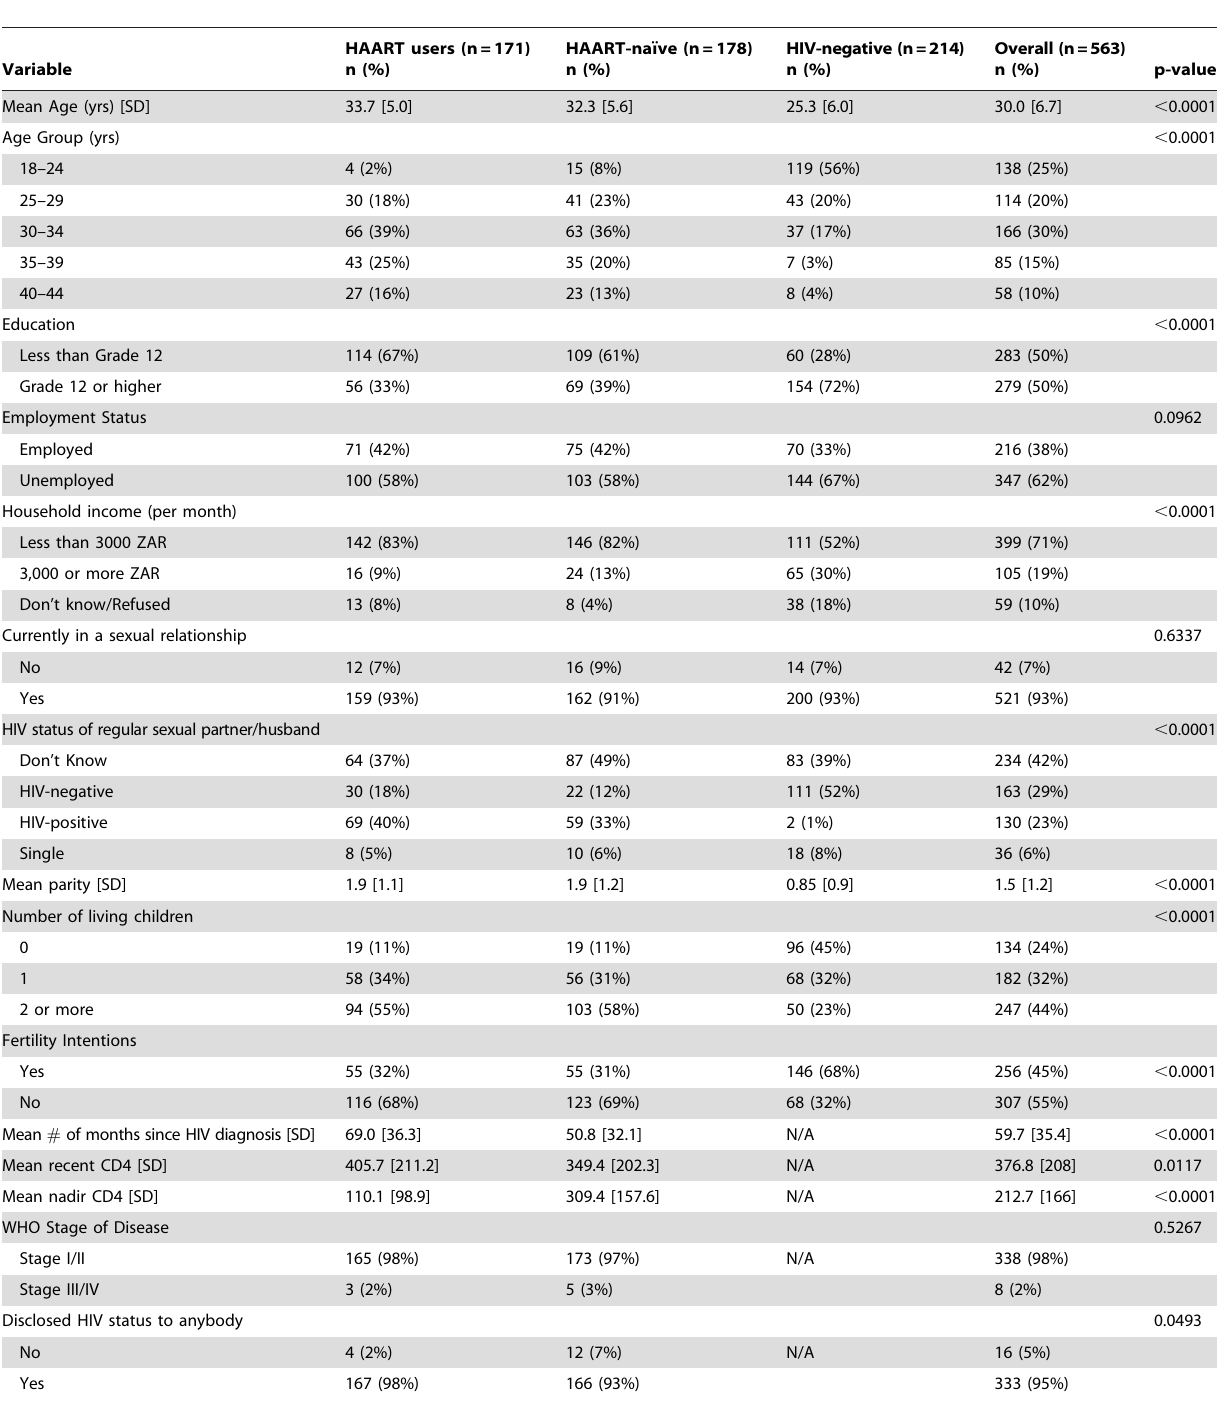
Table 1. Baseline characteristics of HIV-positive (HAART users and HAART-naı¨ve) and HIV-negative women (aged 18–44 years, currently sexually active and non-pregnant) in Soweto, South Africa (n=